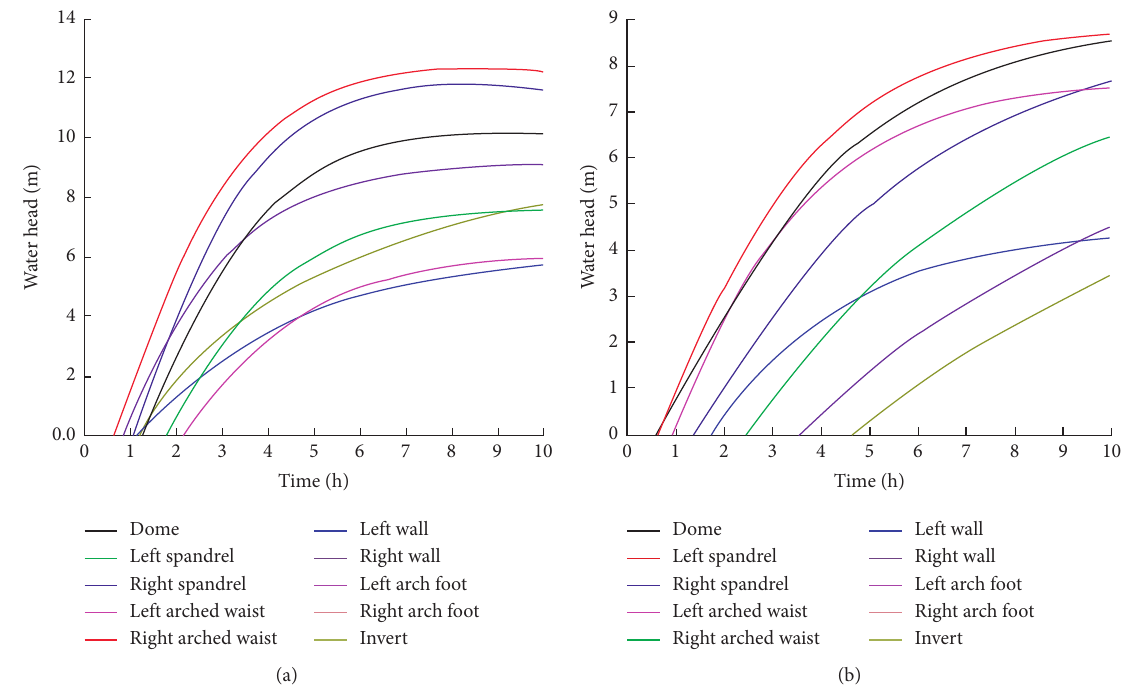
Figure 13: Water pressure at the monitoring point of the tunnel: (a) left line; (b) right line. Table 12: Mechanics parameters of surrounding rock and lining structure.